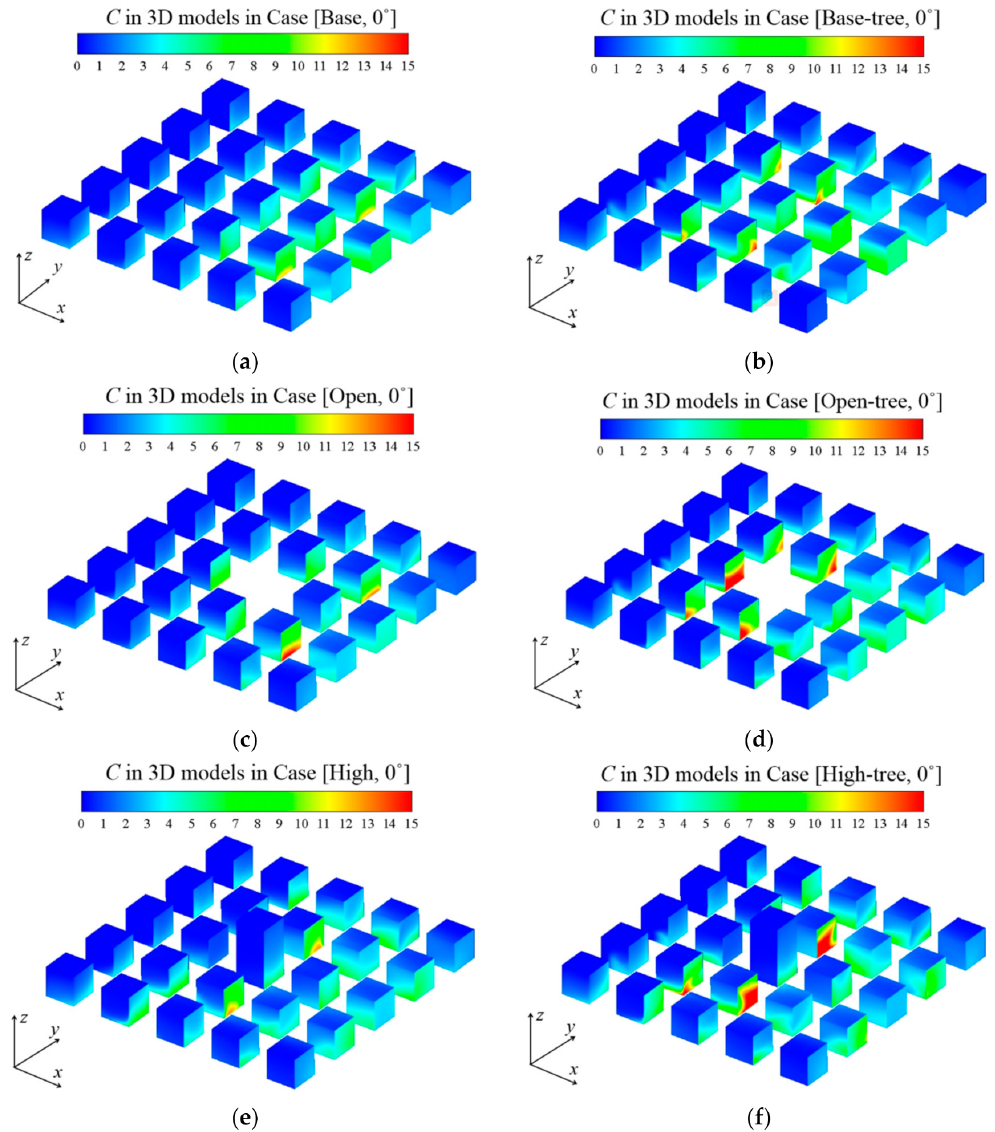
Figure 9. CO concentration ( C ) at building walls in 3D models: ( a ) Case [Base, 0 ◦ ], ( b ) Case [Base-tree, 0 ◦ ], ( c ) Case [Open, 0 ◦ ], ( d ) Case [Open-tree, 0 ◦ ], ( e ) Case [High, 0 ◦ ] and ( f ) Case [High-tree, 0 ◦